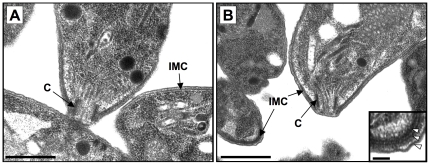
Transmission electron microscopy of TgPhIL1 knockout parasites.The ultrastructure of the conoid (C), IMC, and spacing between the IMC and plasma membrane is indistinguishable in (A) wild-type (RH) and (B) RHΔTgPhIL1 parasites. Scale bars  = 1 µm. Inset shows an enlarged portion of the RHΔTgPhIL1parasite from the lower left corner of panel B; the normal trilaminar structure of the pellicle is evident (arrowheads). Scale bar  = 0.1 µm.